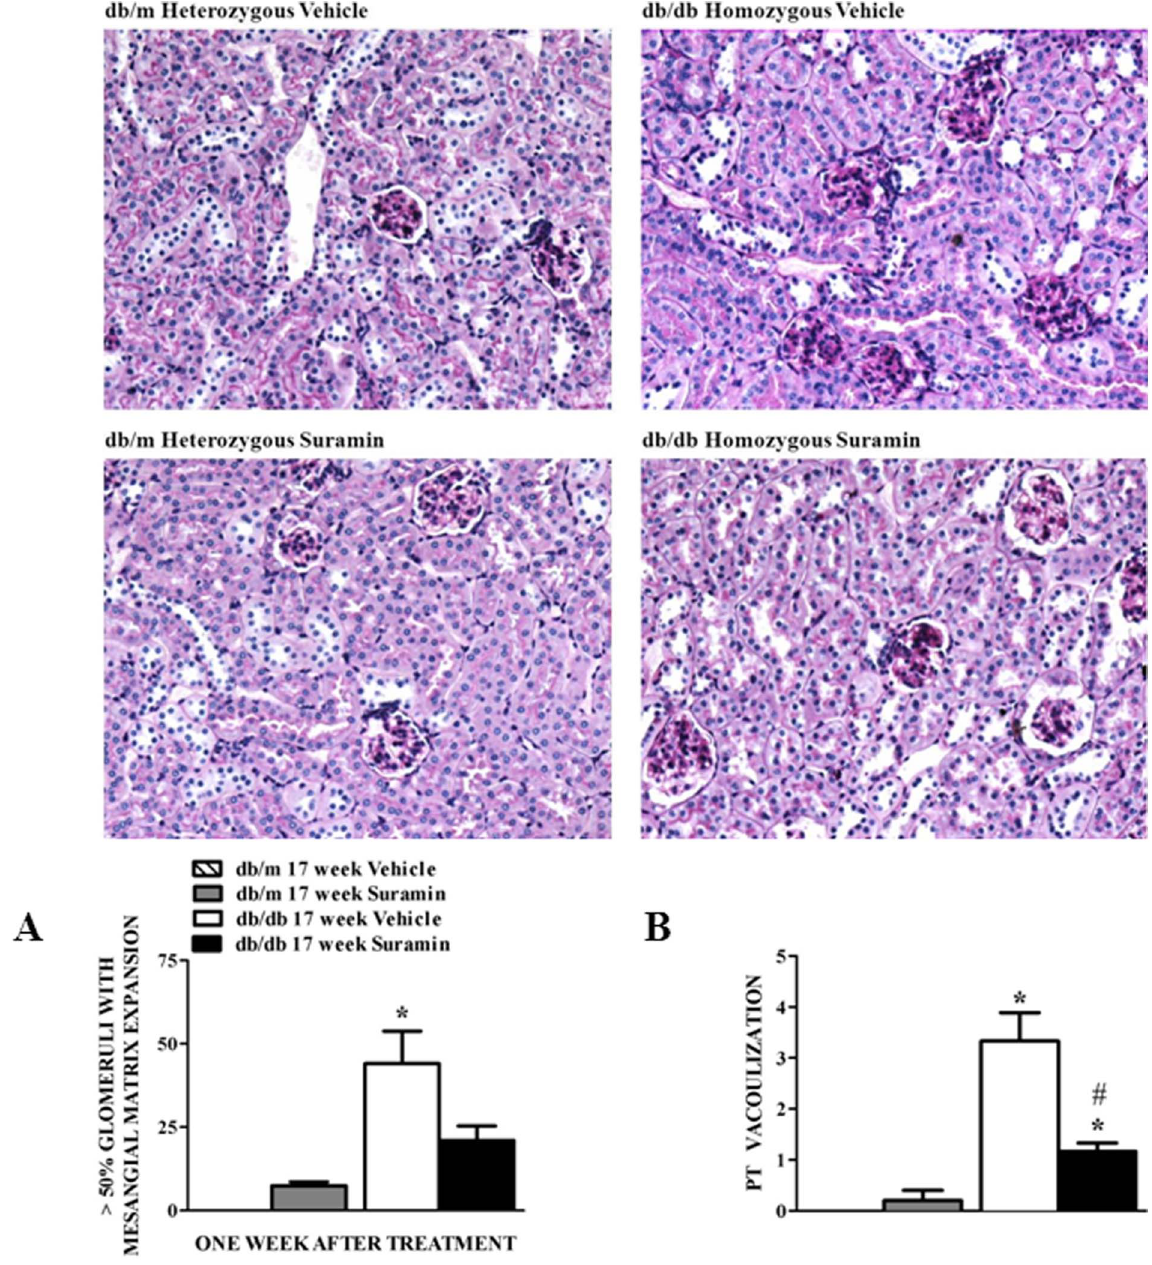
Figure 6. Effect of delayed administration of suramin on renal injury in 17 week db/db mice. Mice were treated as described in Figure 1. Representative photomicrographs of PAS-stained kidney sections from 17 week non-diabetic and diabetic mice 6 suramin intervention, respectively. ( A ). Quantitation of glomeruli with more than 50% of their volume occupied by mesangial matrix in 17 week non-diabetic and diabetic mice 6 suramin intervention. ( B ) Quantitation of proximal tubules with vacuolization in 17 week non-diabetic and diabetic mice 6 suramin intervention. Data are expressed as mean 6 SE (n=6). * Significantly different from respective non-diabetic db/m mice. ( p # 0.05). # Significantly different from vehicle-treated diabetic db/db mice. ( p # 0.05). PT , Proximal tubule. All fields were chosen from the cortical regions of the kidney sections. Original magnification, 200 X. It should be noted that we could not detect any glomeruli with mesangial matrix expansion or proximal tubules with vacuolization in the vehicle-treated non-diabetic db/m control mice